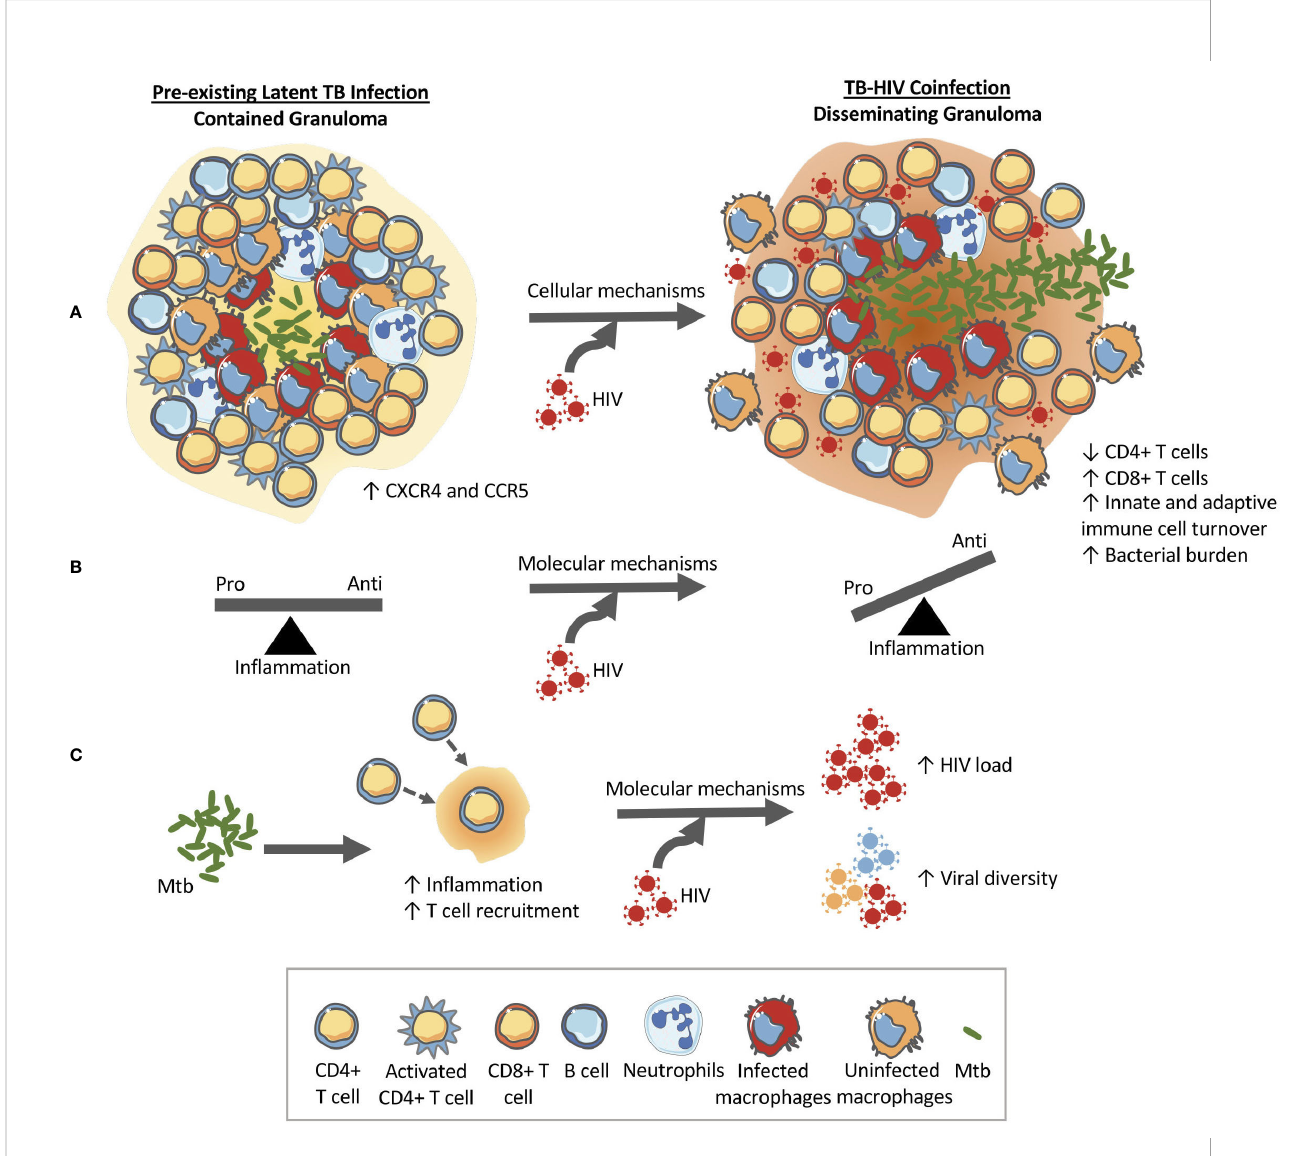
FIGURE 1 HIV changes the structure and function of the granuloma in pre-existing LTBI allowing for bacterial growth and dissemination. (A) Cellular level changes: An example granuloma classi fi ed as contained (bacteria localized) made up of CD4+ and CD8+ T cells, B cells, macrophages, and neutrophils that transforms into a disseminating granuloma upon HIV infection. The granuloma is rich in HIV susceptible cells (CXCR4 and CCR5 cells) that can help accelerate CD4+ T cell destruction. Granulomas during coinfection have been shown to contain higher CD8+ T cells and have higher rates of macrophage turnover. These cellular changes at the granuloma level ultimately alter the function of the granuloma which can lead to increased bacterial load and dissemination. (B) Molecular mechanism #1: HIV has been shown to have detrimental impacts on the functionality of CD4+ T cells and therefore the balance between pro-and anti-in fl ammatory cytokines produced by the local immune cells is thrown into dysregulation. The change in the cytokine milieu can facilitate granuloma dissolution. (C) Molecular mechanism #2: The immune response to Mtb results in an increase in in fl ammation and T cell recruitment to the site of infection. This Mtb -induced in fl ammation and availability of HIV susceptible cells within the granuloma (CXCR4 and CCR5 cells) have been implicated in the increased viral loads and increased viral diversity found in coinfection. An increase in viral load would lead to local destruction of the cells in the granuloma therefore aiding bacterial